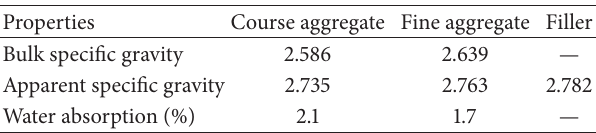
Table 2: Test results on aggregate specific gravity and